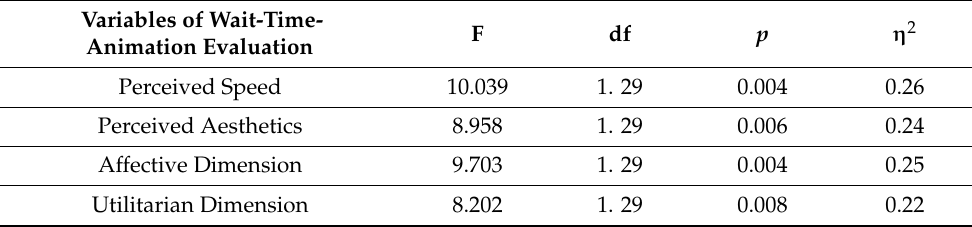
Table 3. Results of the one-way repeated measures MANOVA for the differences of wait-time- animation evaluation depending on design (tests of within-subject contrasts).